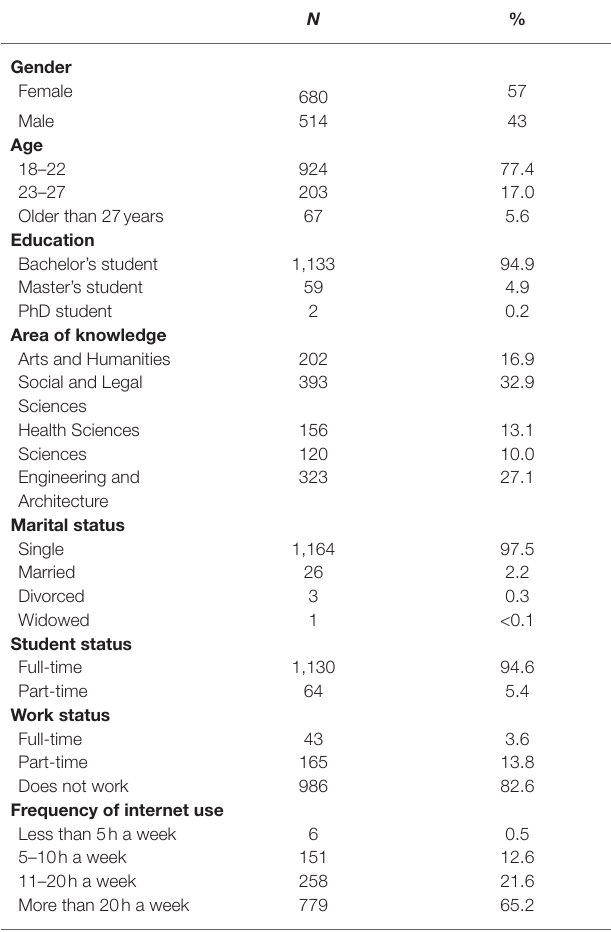
TABLE 1 | Sociodemographic characteristics of the